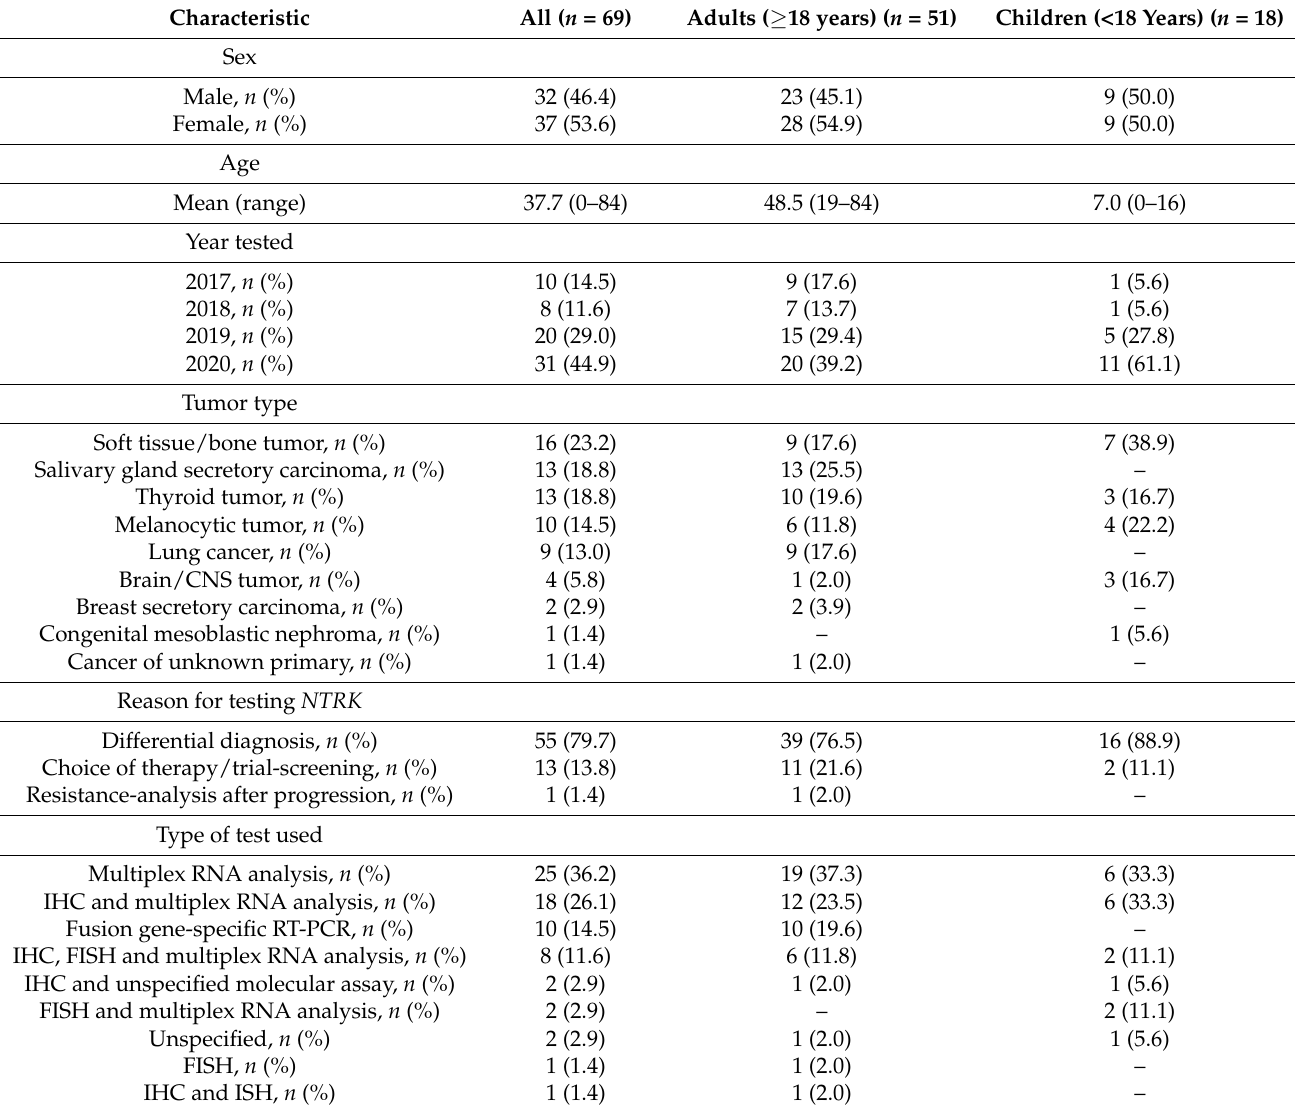
Table 1. Characteristics of patients with a molecular-confirmed NTRK1-3